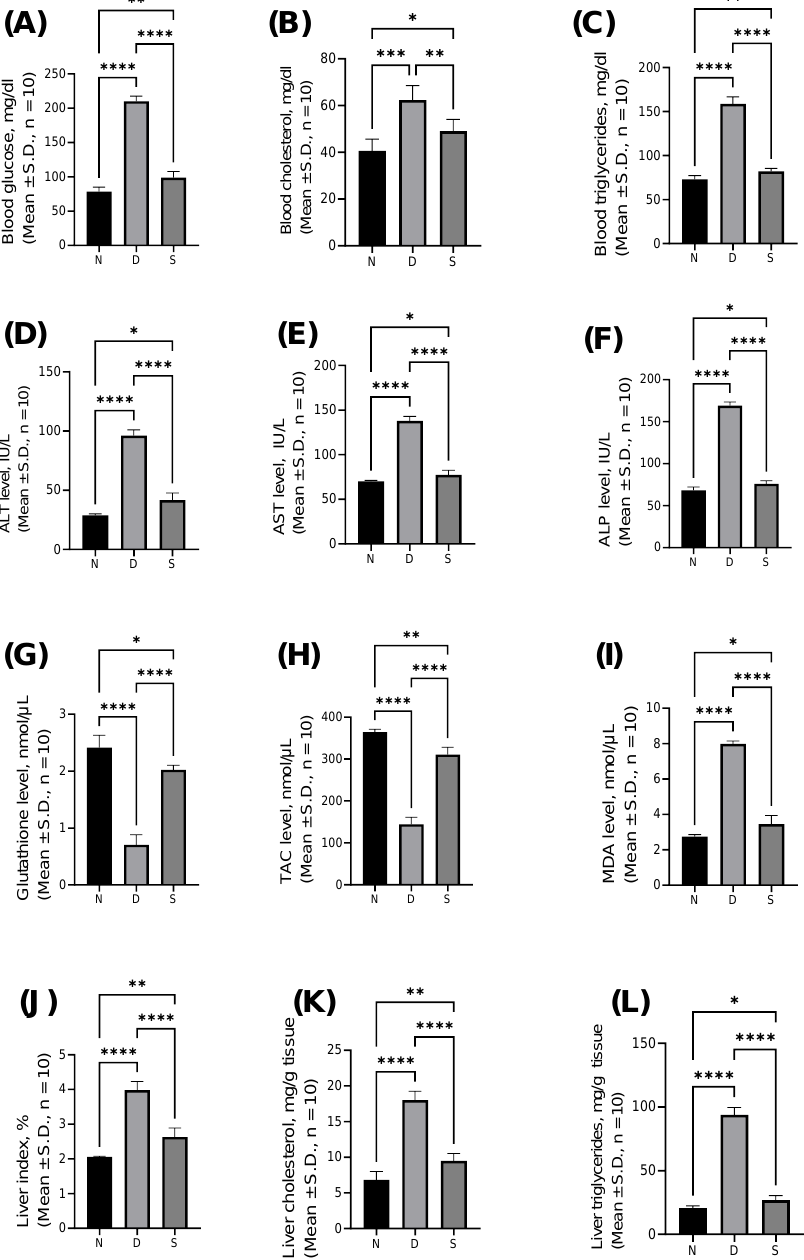
Figure 1. The biochemical parameters of Swietenine effect in serum and liver samples in ( A ) blood glucose, ( B ) blood cholesterol, ( C ) blood triglycerides, ( D ) alanine aminotransferase, ALT levels, ( E ) aspartate aminotransferase, AST levels, ( F ) alkaline phosphatase, ALP levels, ( G ) glutathione level, ( H ) total antioxidant capacity, TAC levels, ( I ) malondialdehyde, MDA level, ( J ) liver index, ( K ) liver cholesterol and ( L ) liver triglycerides. N, normal group; D, diabetic mice group; S, treatment with swietenine (80 mg/kg) group. ns: Not significant; * p < 0.05, ** p < 0.01, *** p < 0.001, **** p < 0.0001.